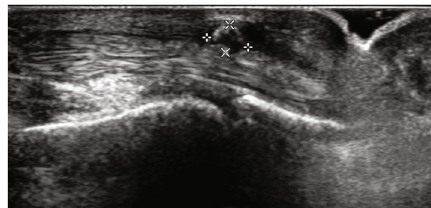
Figure 1: Ultrasound examination of the fourth fi nger of her left hand shows an avascular mass of about 6 × 2 mm , attached to the fl exor tendons, anechogenic with an echogenic core.